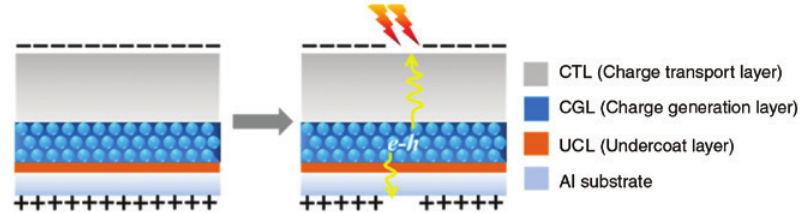
Figure 4: The configuration and the photoinduced discharging process of a negatively charged dual-layered OPC.